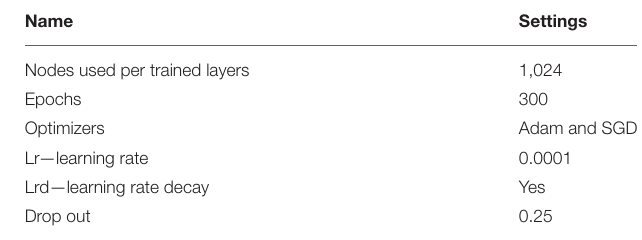
TABLE 1 | Data distribution for different classes.